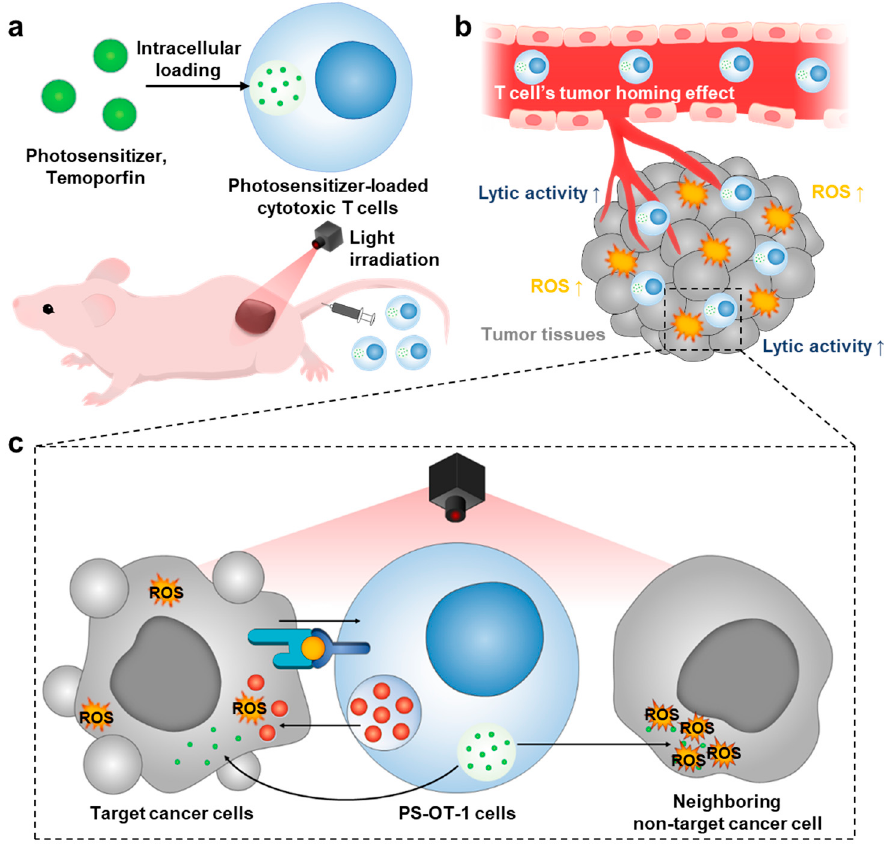
Figure 1. Adoptive transfer of photosensitizer (PS)-loaded cytotoxic T cells for combinational photodynamic therapy (PDT) and cancer immunotherapy. ( a ) Photosensitizer (PS) is loaded into cytotoxic T cells (OT-1 cells), resulting in PS-OT-1 cells. ( b ) When PS-OT-1 cells are intravenously injected into the tail vein, they accumulate within the targeted tumor tissues owing to T cells’ tumor homing effect. ( c ) Upon light irradiation, PS-OT-1 cells can effectively eradicate the tumor cells that are directly attacked by T cells, as well as neighboring non-target cancer cells that are not immediately recognized by T cells in the tumor tissues by combinational e ff ect of PDT and ACT.